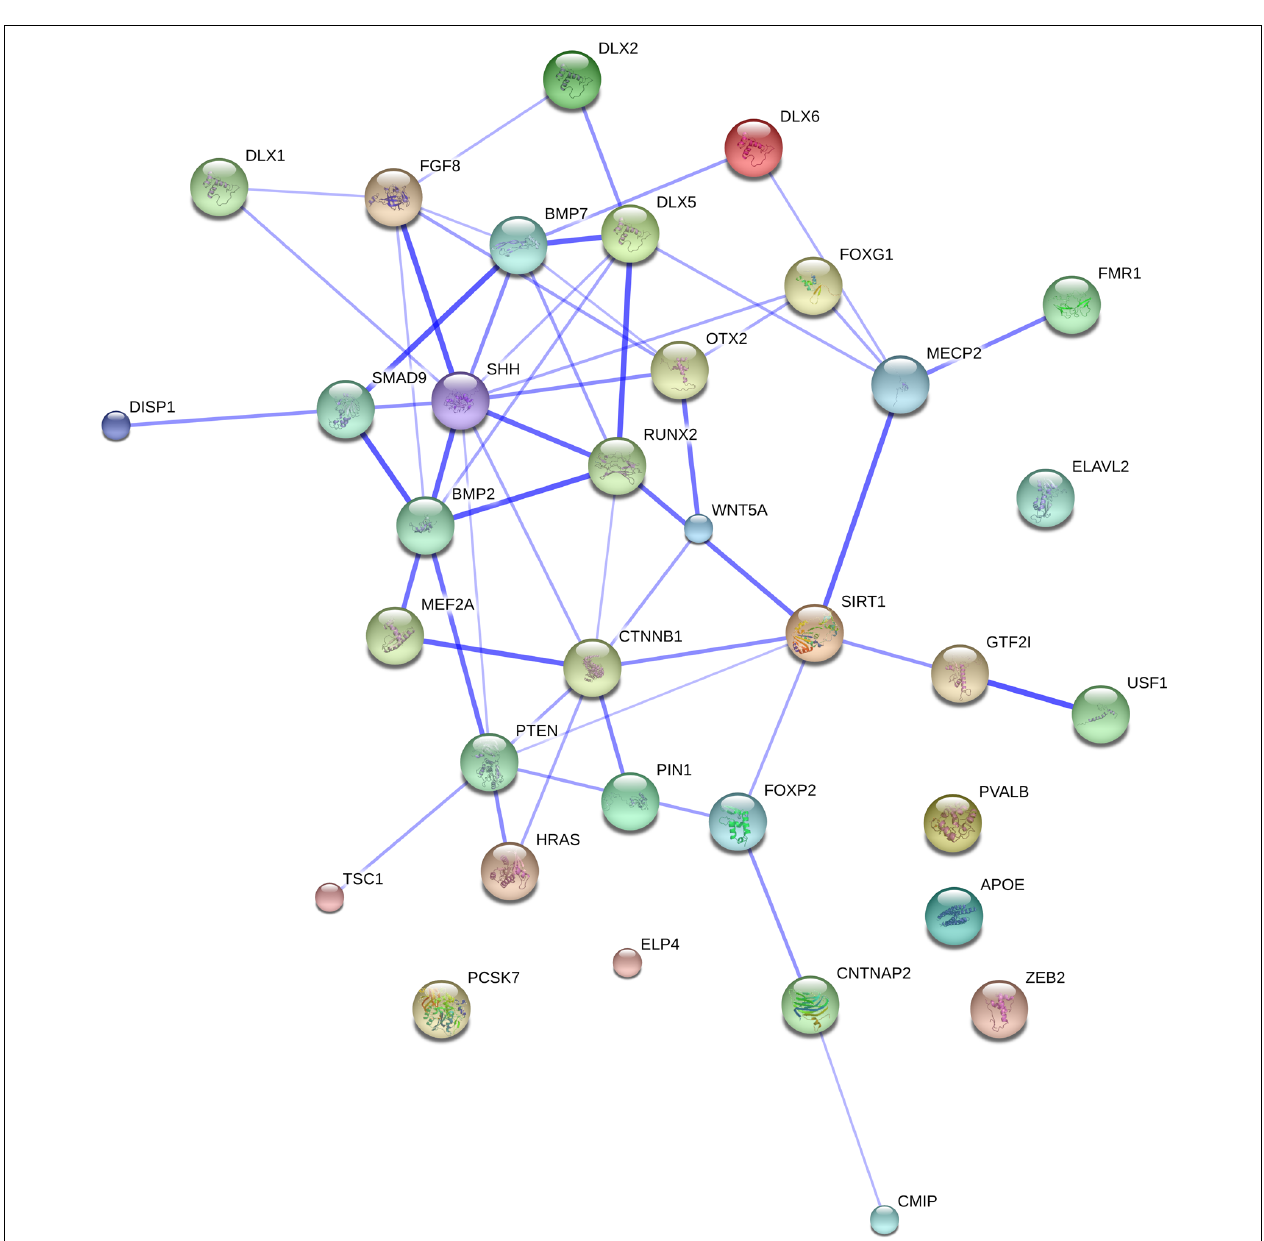
FIGURE 3 |The whole set of proteins encoded by the candidates genes for the language-ready brain. The network was generated by String 9.05, a database of known and predicted protein interactions, either physical or functional (Szklarczyk etal., 2011).The medium confidence value was 0.04.